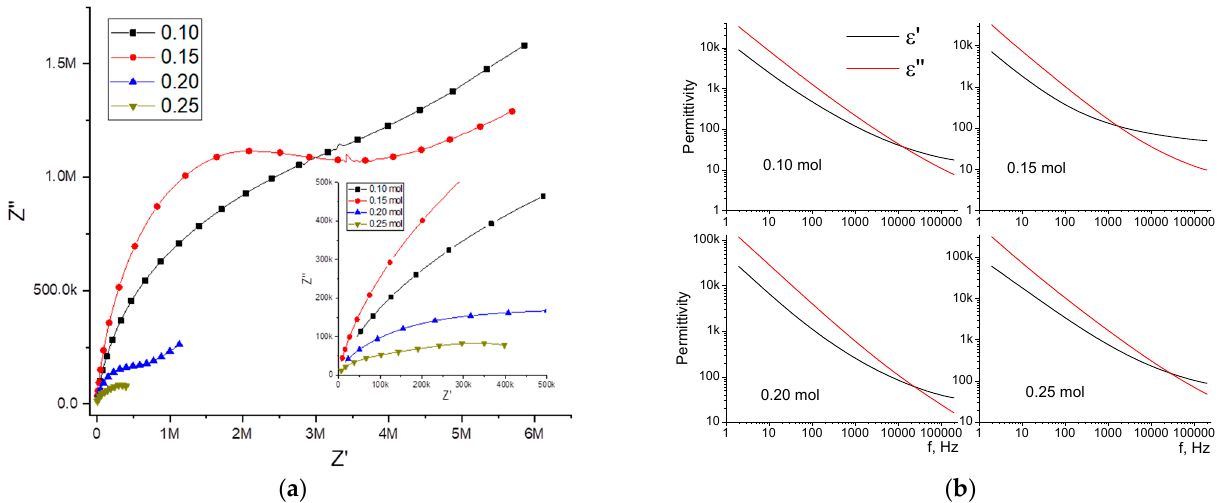
Figure 8. Cole–Cole diagrams Z ″ (Z ′ ) ( a ) and frequency dependences of the complex permittivity ( b ).